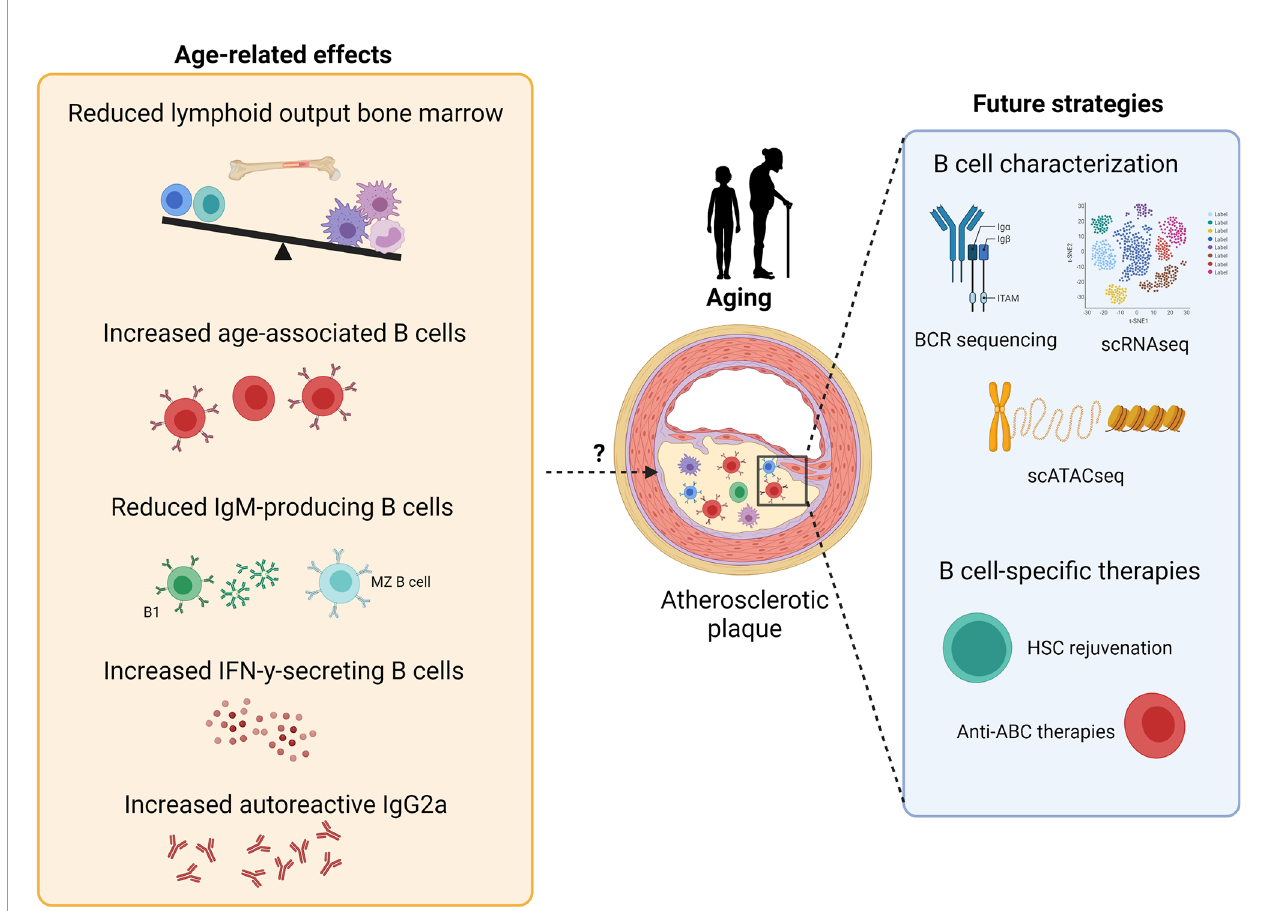
FIGURE 2 | Potential effects of aging on atherosclerosis development and future strategies for B cell-speci fi c treatment against atherosclerosis. B cell aging leads to reduced lymphoid output, reduced numbers of IgM-producing B cells and an increase in age-related B cell subsets, thereby resulting in both pro- and anti- atherogenic effects. Further characterization of B cells in atherosclerosis via single-cell RNA sequencing, BCR sequencing and single-cell assay for transposase- accessible chromatin sequencing should give further insights for the development of B cell-speci fi c therapies against atherosclerosis, such as HSC rejuvenation and anti-ABC